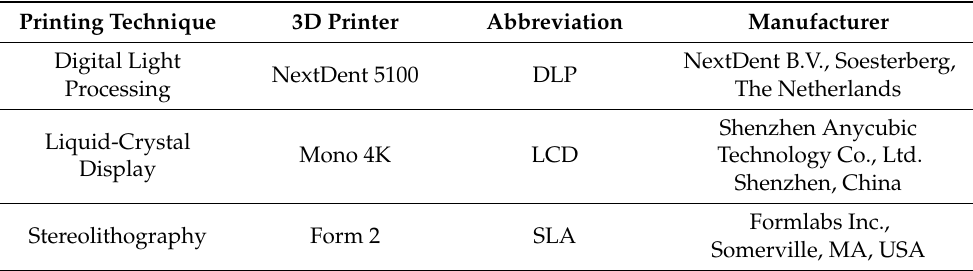
Table 3. Printing and post-processing parameters .